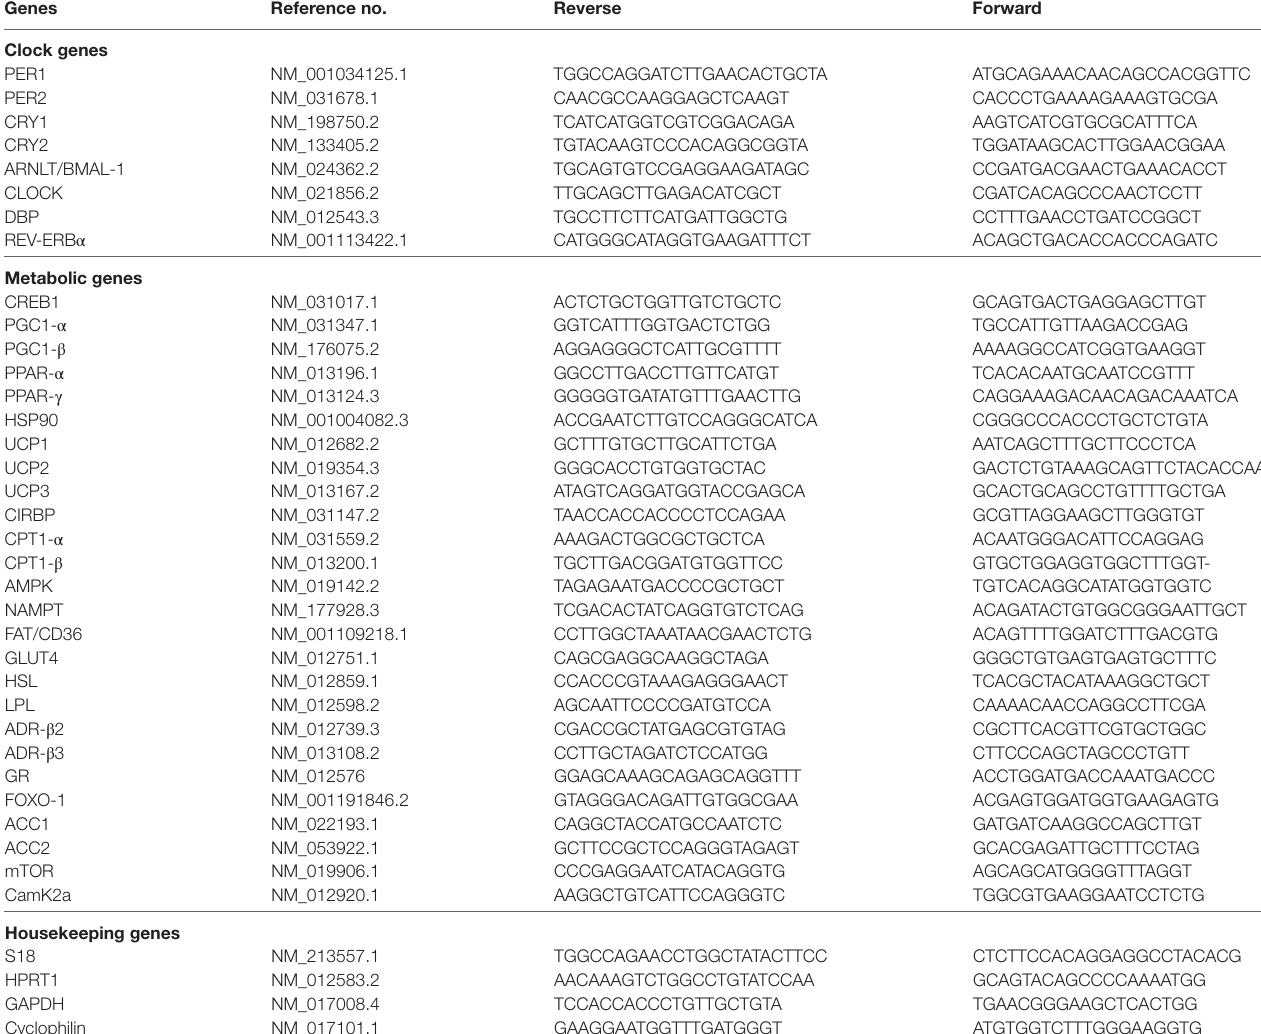
TaBle 1 | Information about gene